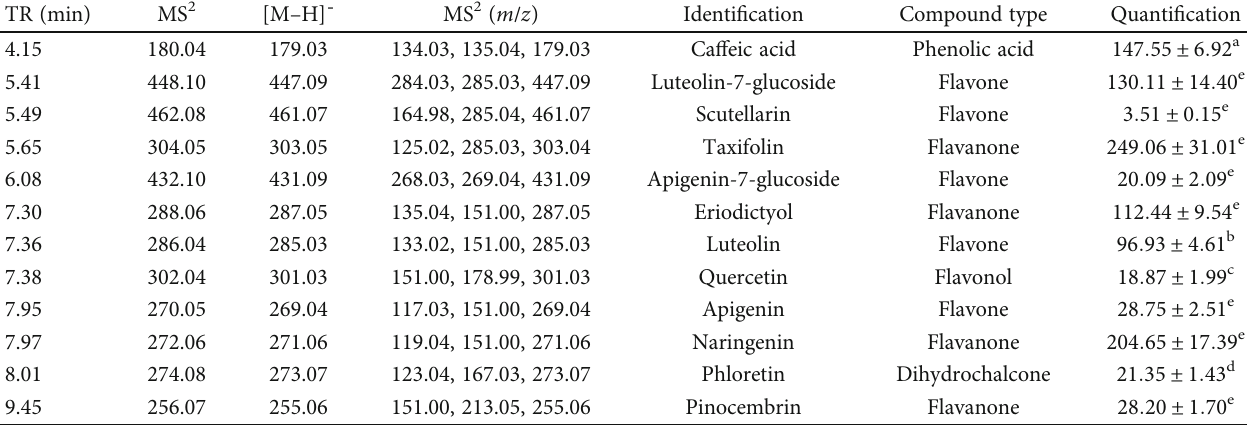
Table 8: Identi fi cation and quanti fi cation of phenolic compounds in microencapsulated powder of oregano ( Lippia graveolens ) extracts. TR (min)